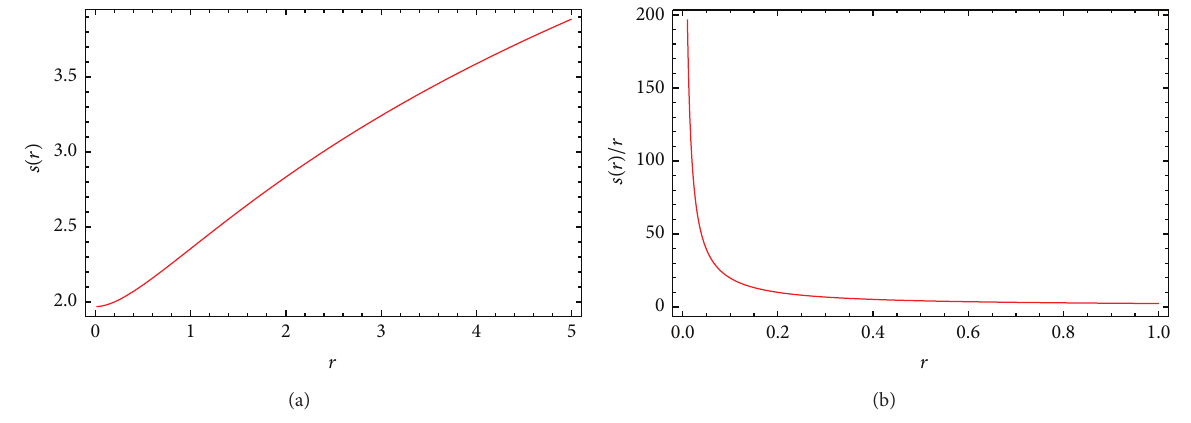
Figure 1: Plots of 𝑠(𝑟) (a) and 𝑠(𝑟)/𝑟 (b) versus 𝑟 for exponential